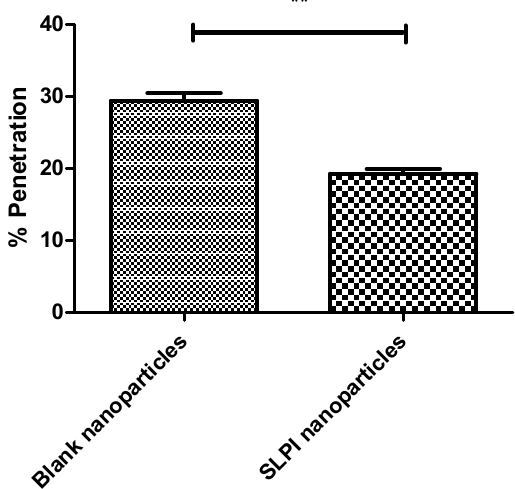
Figure 4. Ability of rhodamine loaded particles to penetrate CF mucus. Mean ± S.D, N = 3, (** p < 0.01).